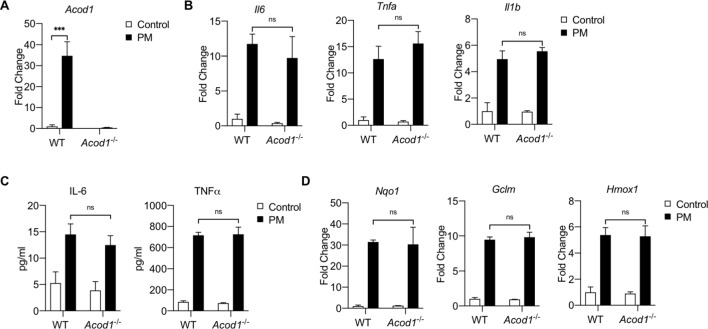
Acod1 and Itaconate are not required for PM-induced inflammatory response in tissue resident alveolar macrophages.Primary tissue resident alveolar macrophages were isolated from WT and Acod1-/- mice and cultured in vitro for 2 hours before treatment with PM (20 µg/cm2) for 24 hours. Gene expression was measured by qPCR. (A) Acod1 gene expression is significantly induced by PM treatment only in WT alveolar macrophages. (B) Inflammatory genes (Il6, Tnfa, Il1b) were equally upregulated by PM treatment in both WT and Acod1-/-alveolar macrophages. (C) Cytokine levels of IL-6 and TNFα in media as measured by ELISA; IL-6 and TNFα levels increase with PM treatment in both WT and Acod1-/-alveolar macrophages equally. (D) NRF2 target genes (Nqo1, Gclm, Hmox1) were upregulated with PM treatment as measured by qPCR, with no difference between WT and Acod1-/- cells. Significance was analyzed with one-way ANOVA corrected with Bonferroni’s post hoc test for multiple comparisons, *p<0.05, **p<0.01, ***p<0.001.